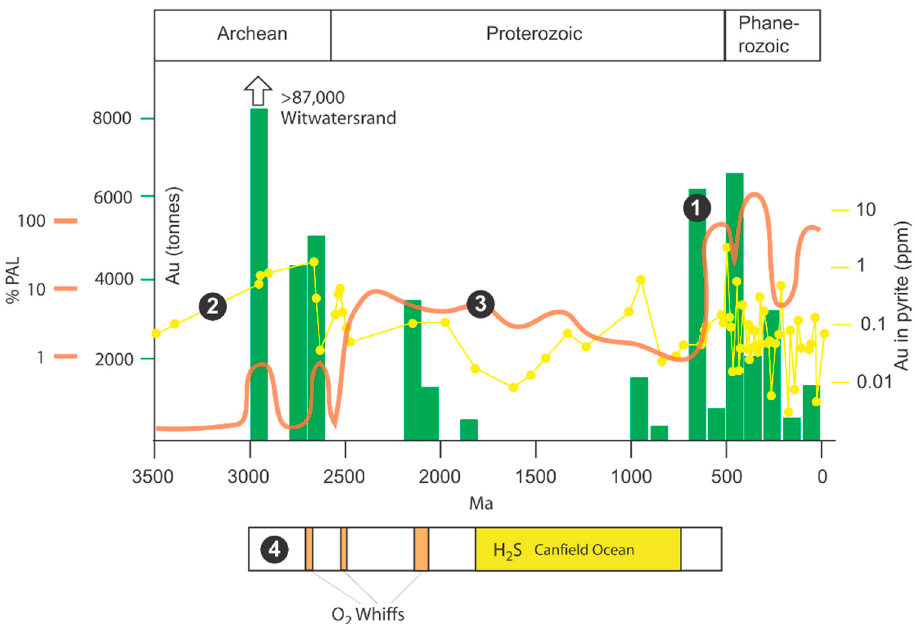
Figure 2. Secular distribution of the orogenic gold deposits (1—[16]) in relation to gold contents of nodular pyrites from black shales (2—geometric mean of LA-ICP-MS analyses from time interval: [16]), an estimate of oxygenation based on Se content of nodular pyrite, expressed as a percentage of present atmosphere level (% PAL—3—[17]), and O 2 whiffs and Canfield ocean (4—[18]). The high levels of Au in black shales correspond to the greatest periods for orogenic gold deposit formation.